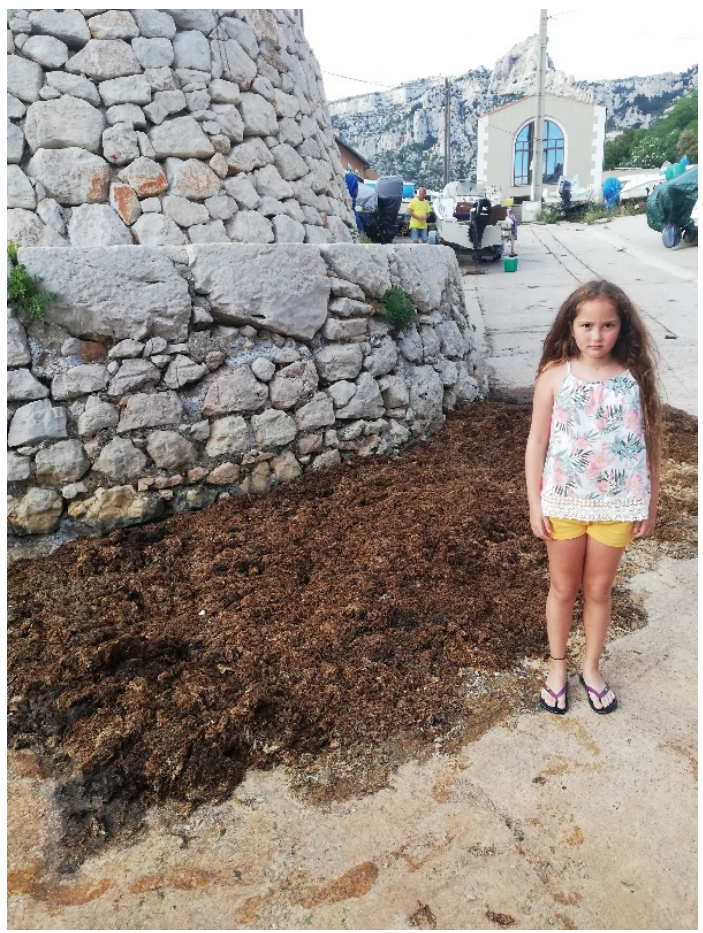
Figure 5. A heap of dry fragments of Rugulopteryx okamurae cast ashore at the head of the Callelongue Cove (between Sites 2 and 4, see Figure 2), early June 2021. The girl (Emma Thibaut, 140 cm tall) gives the scale. Photo © Thierry Thibaut.